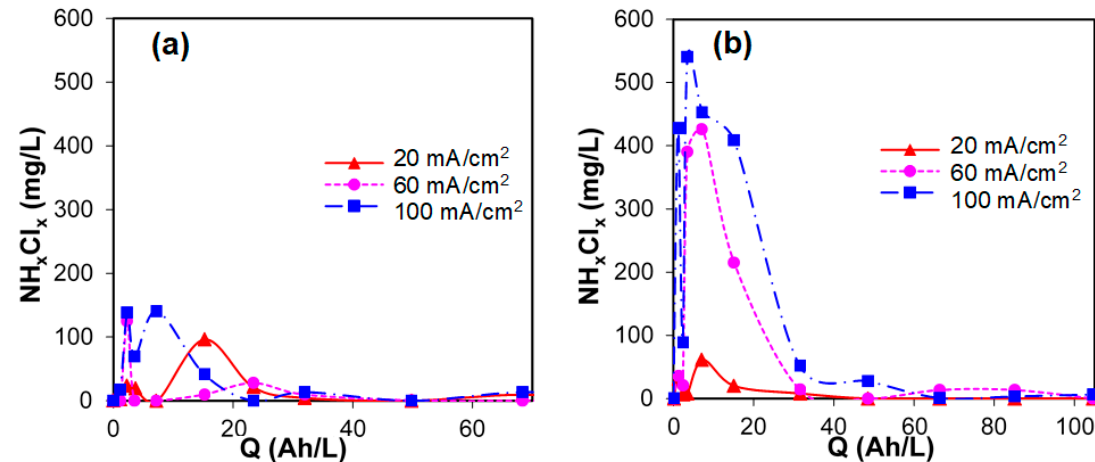
Figure 9. Changes in the concentration of chloramines with the specific electric charge during electrolytic treatment of synthetic urine at pH = 5.5 and at room temperature (25 °C) using BDD ( a ) and DSA ( b ) anodes and a stainless steel cathode with a flow rate of 800 mL/min at different current densities: ( ▲ ) 20 mA/cm 2 , ( ● ) 60 mA/cm 2 , and ( ■ ) 100 mA/cm 2 .